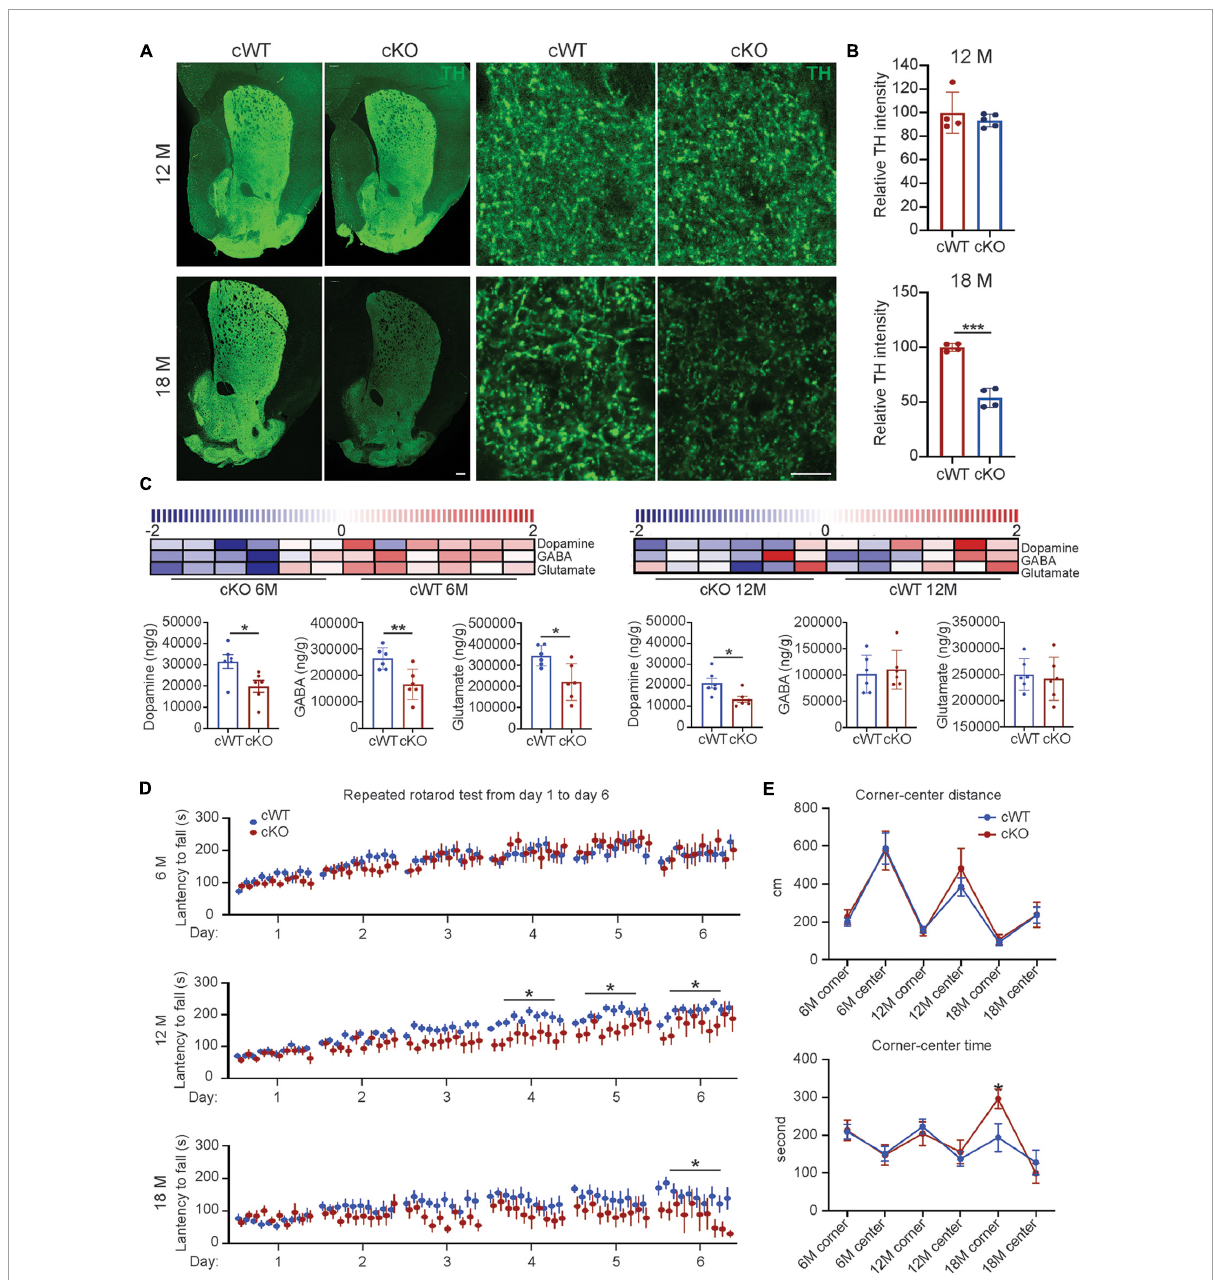
FIGURE2 Striatal pathology triggered movement abnormalities in Pitx3 cKO mice. (A) IFC staining of TH in the striatal sections from 12- to 18-month-old Pitx3 cWT and Pitx3 cKO mice (scale bar: 200 µ m; high-magnification, 10 µ m). (B) Quantification of relative TH intensity in the striatum from 12- to 18-month-old Pitx3 cWT and Pitx3 cKO mice ( N = 4 mice per genotype; all males except for two females in 6-month-old Pitx3 cKO and 12-month-old Pitx3 cWT ). Unpaired t -test, *** p = 0.0006 (18 months). (C) Levels of neurotransmitter in 6- ( N = 6 mice per genotype; all males) and 12-month-old Pitx3 cKO and Pitx3 cWT mice ( N = 6 mice per genotype; all males). The scaled intensity of three metabolites is relatively depicted according to the color key shown on the above. Red indicates high intensity levels; blue, low intensity levels. Unpaired t -test, * p = 0.026 (Dopamine, 6M), ** p = 0.0083 (GABA, 6M), * p = 0.012 (Glutamate, 6M), * p = 0.0202 (Dopamine, 12M). (D) The latency to fall from rotarod was recorded from Pitx3 cWT and Pitx3 cKO mice at 6 ( N = 11–13 mice per genotype; all males), 12 ( N = 11–15 per genotype; all males) and 18 months of age ( N = 9–11 mice per genotype; all males). 2way ANOVA analysis with Sidak’s multiple comparisons test at 12 and 18 months, * p = 0.0171 (day 4, 12 months), * p = 0.0202 (day 5, 12 months), * p = 0.0376 (day 6, 12 months), * p = 0.0326 (day 6, 18 months). (E) Center-corner preference analyses for Pitx3 cWT and Pitx3 cKO mice at 6 ( N = 11–13 mice per genotype; all males), 12 ( N = 12–14 per genotype; all males), and 18 ( N = 9–10 mice per genotype; all males) months of age. 2way ANOVA analysis with Sidak’s multiple comparisons test, * p = 0.05 (time in corner at 18